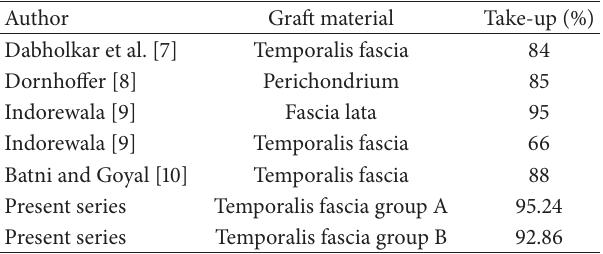
Table 2: Comparison of graft uptake rates of different